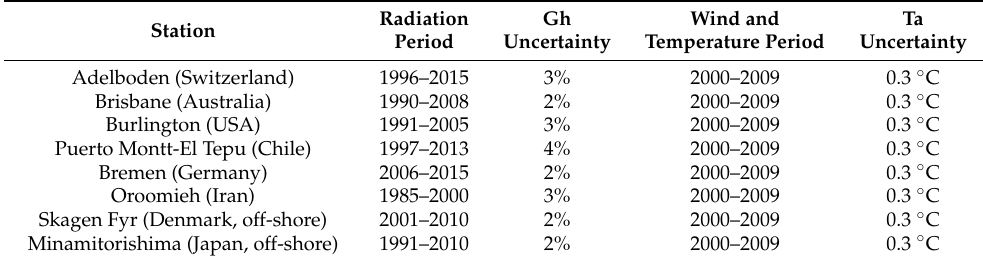
Table 4. Time period and uncertainty of available data in